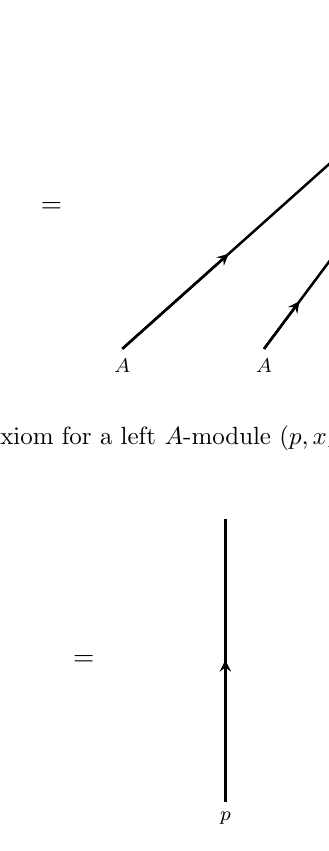
Figure 16 . Unit axiom for a left A -module ( p; x L